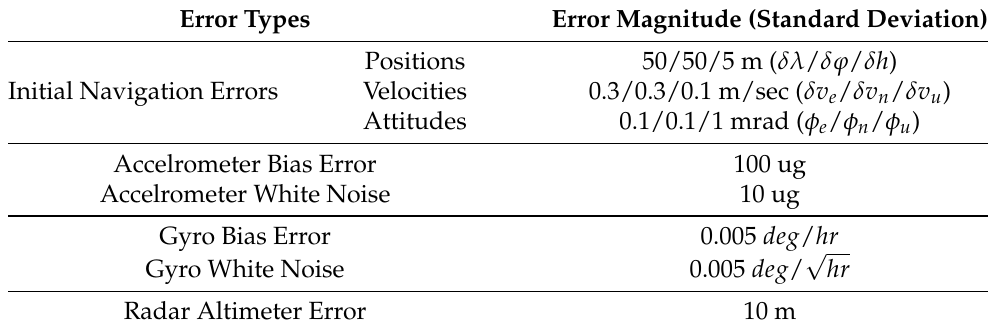
Figure 11. Ground trajectory and terrain elevation for INS/TRN simulation. Table 2. Initial navigation and sensor error configuration for tightly-coupled INS/TRN